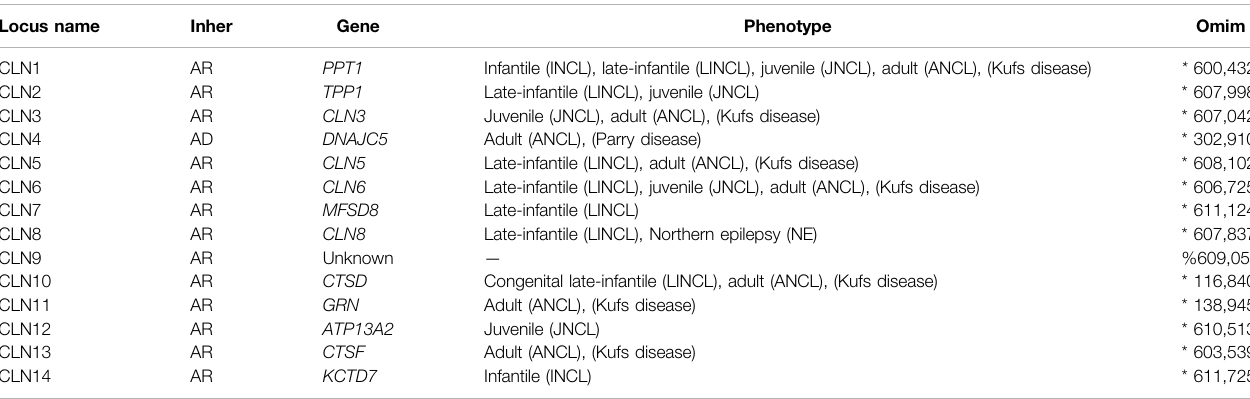
TABLE 1 | NCL classi fi cation based on associated